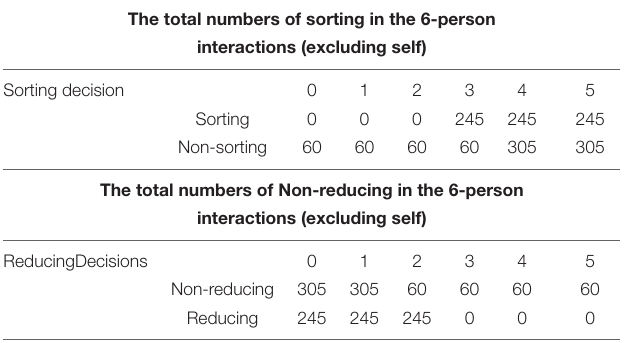
TABLE 3 | Experimental procedures for four experiments. Treatment No.